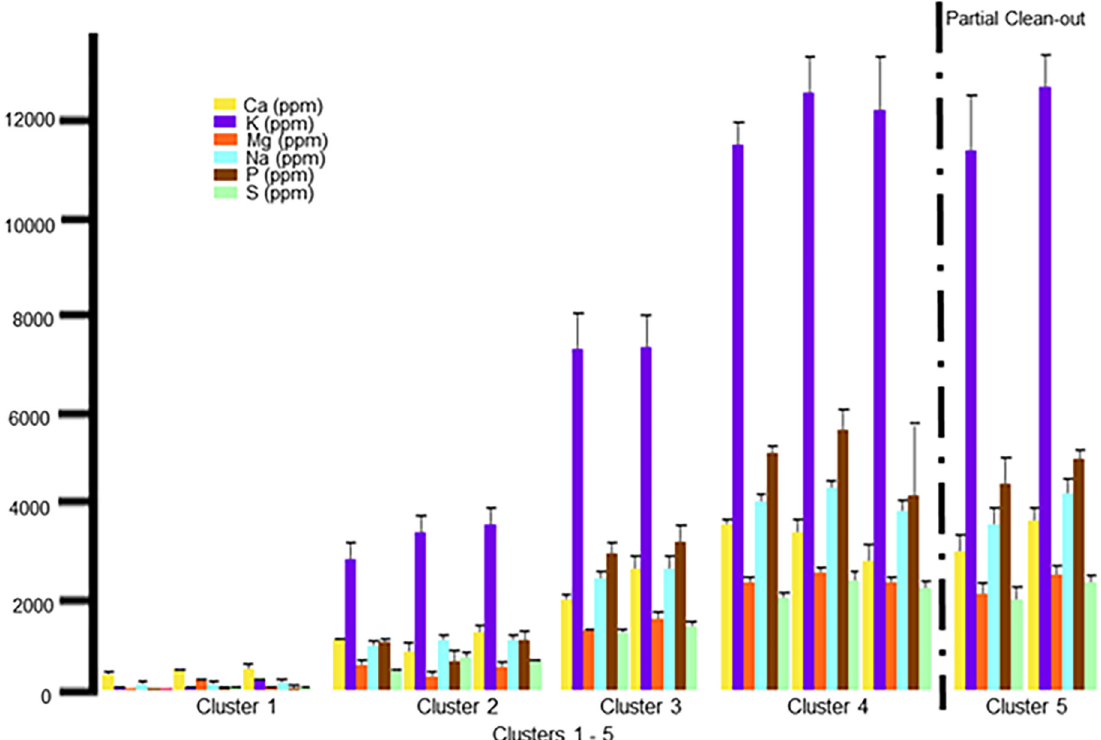
Fig 5. Mean values for the parameters Ca, K, Mg, Na, P and S. Mean values for the parameters Ca, K, Mg, Na, P and S, expressed as ppm, with standard deviation error bars are seen in this graph. In order from left to right on the graph is Cluster 1: Native, Pad and Flock1; Cluster 2: Flock 2, 10 and 11; Cluster 3: Flocks 3 and 4; Cluster 4: Flocks 5, 6, and 7; and Cluster 5: Flocks 8 and 9. The partial clean-out which occurred between Flock 7 and 8 is marked by a dashed line. doi:10.1371/journal.pone.0128179.g005 Table 3. Key pollutants of environmental interest from poultry manure.